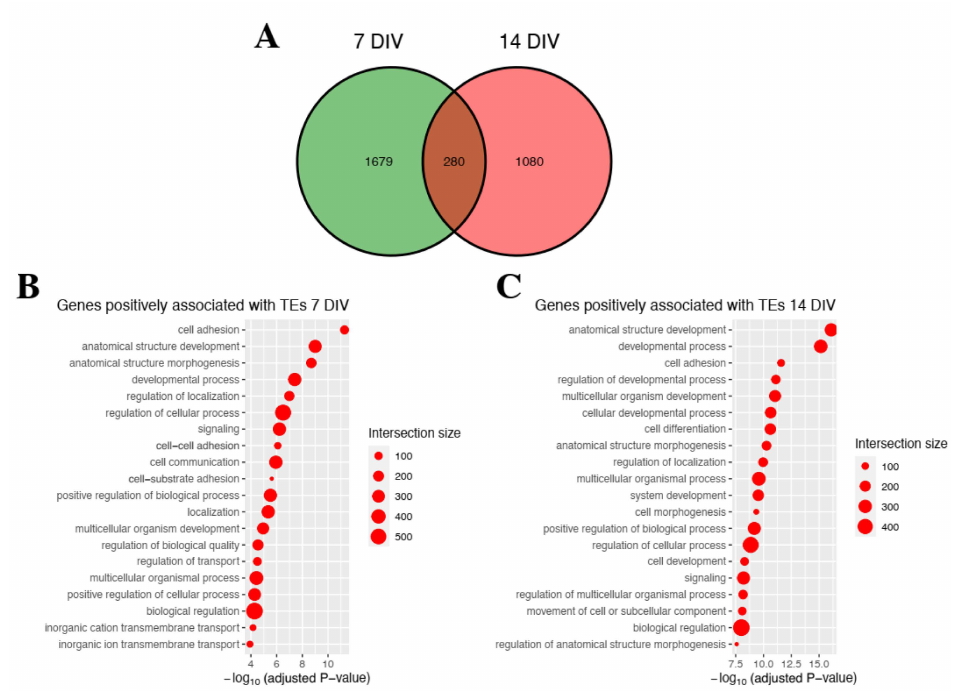
Figure 4. Pathway enrichment analysis for genes associated with differentially expressed TEs iMNs TDP-43 M337V . ( A ) A Venn diagram is shown to indicate the number of gene-TE pairs associated with each time point: 7 (green), and 14 DIV (red). ( B ) Top 20 enriched biological processes of genes positively associated with TEs at 7 DIV. ( C ) Top 20 enriched biological processes of genes positively associated with TEs at 14 DIV. Each list goes in descending order according to their statistical significance. The dot size corresponds to the number of genes associated with the respective biological process (“Intersection size”; see Section